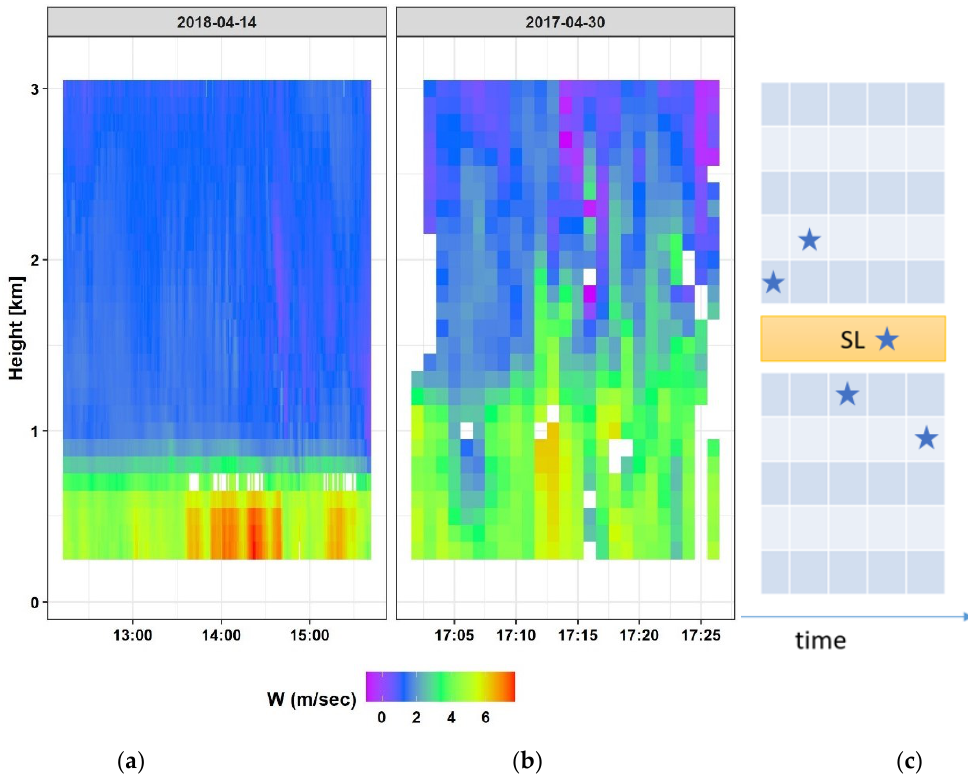
Figure 2. Separation level in stratiform and convective events. The Doppler velocity W is represented for a stratiform event ( a ) and a convective event ( b ). Identifying the separation level for a five-minute window ( c ) requires identifying for each minute the height in which the change in SW is the maximum (blue stars), then finding the mean of the five heights (the height of the layer in yellow).